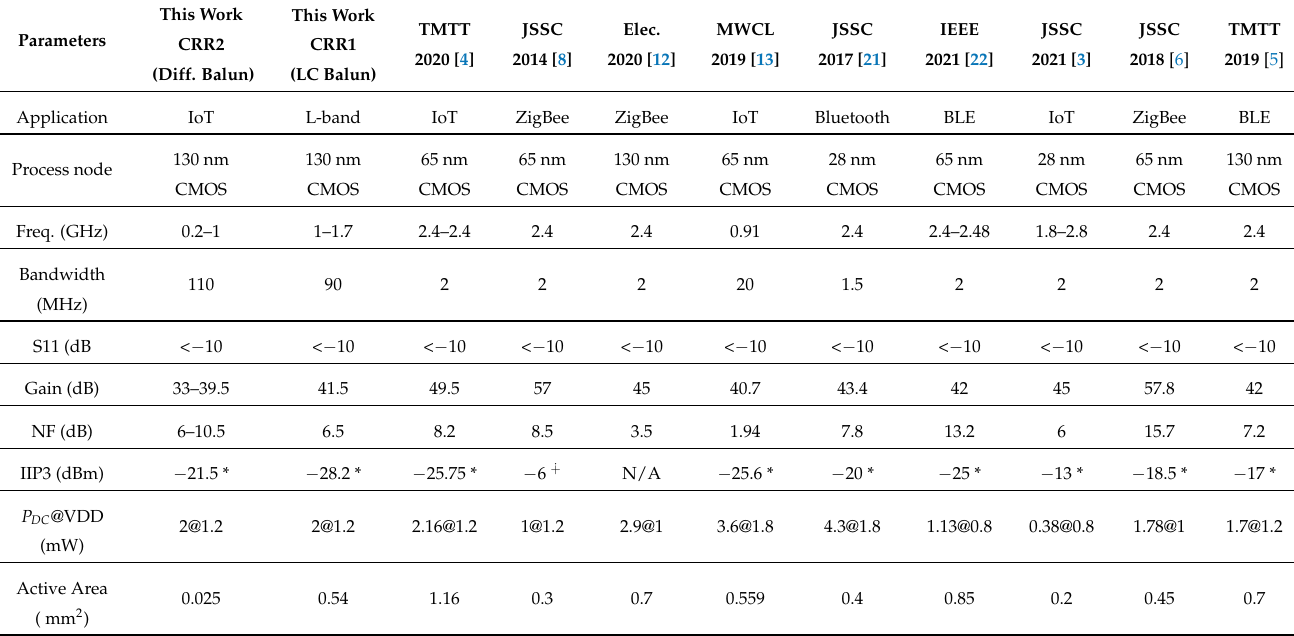
Table 1. Performance summary and comparison to other